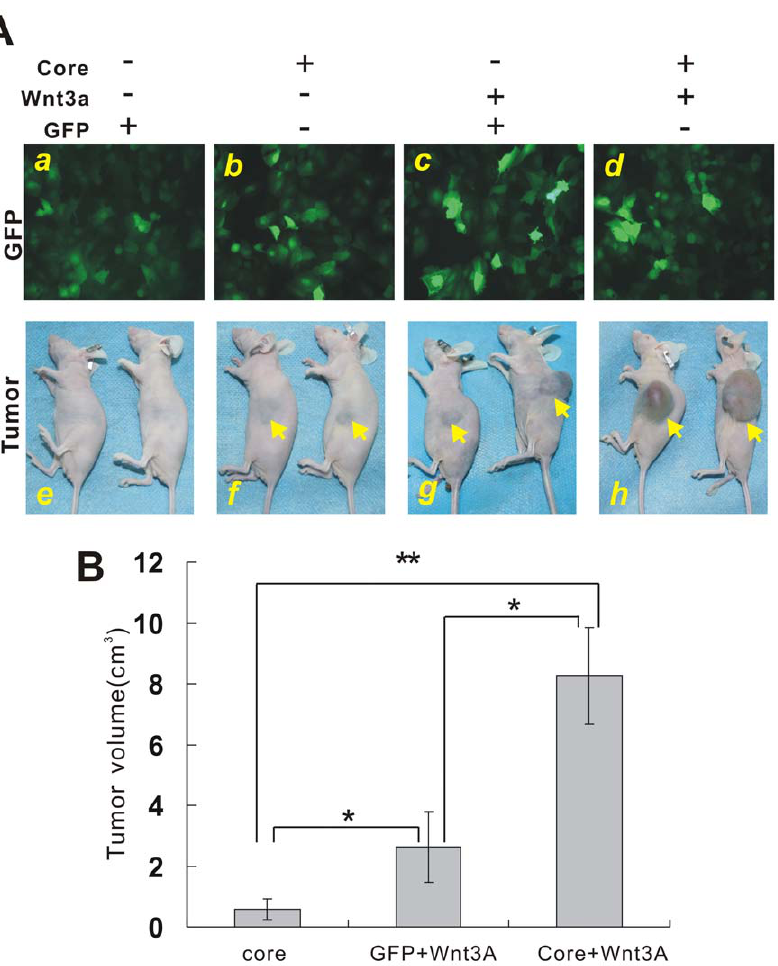
Figure 5. Over-expression of HCV core promotes Wnt3A-induced xenograft tumor growth in vivo. ( A ) Ectopic expression of HCV core in Huh7 cells accelerated Wnt3A-induced tumor growth. Huh7 cells were infected with AdGFP control, Ad-Core, AdGFP plus AdWnt3A or Ad-Core plus AdWnt3A for 15 hr, and the infection efficiency was examined under a fluorescence microscope (Panels a to d ). The infected cells were collected and subjected to subcutaneous injection into the flanks of athymic mice. At 6 weeks post implantation, animals were sacrificed and tumor masses were retrieved. Representative gross images of xenograft tumors are shown (Panels f to h ). Gross tumors are indicated by arrows. Note that GFP-treated Huh7 cells did not form any detectable tumor masses at the end point of the experiment (panel e ). ( B ) Comparison of tumor size in the xenograft model. The infected cells were treated as described in Figure 5A . Tumor sizes were measured at 6 wk after injection and subjected to statistical analysis. * P , 0.05; ** P ,